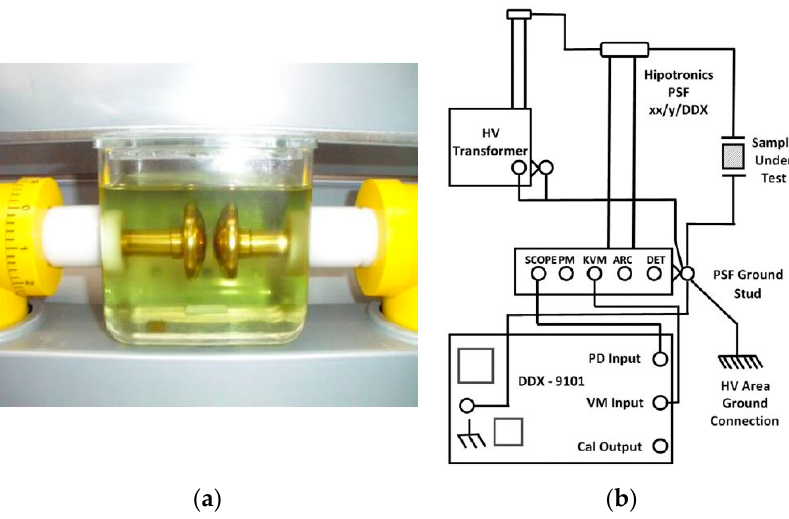
Figure 2. AC BDV and PD apparatuses: ( a ) BAUR DTA test cell with Rogowski electrodes. ( b ) Schematic diagram of the PD setup.